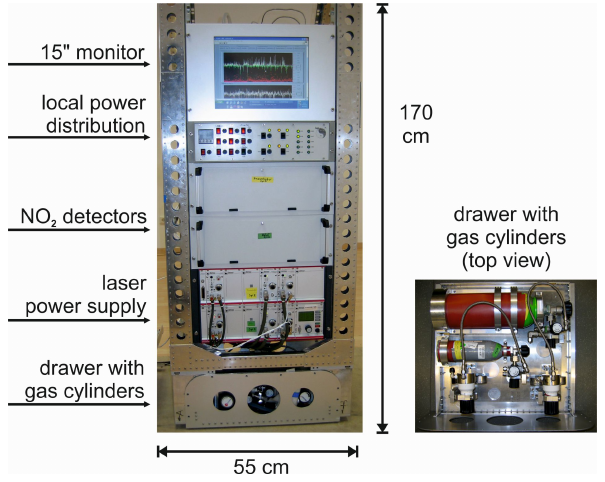
Fig. 2. PeRCEAS rack front side. Rack components which are not visible: PXI computer, temperature-, pressure- and flow controllers, and HALO power supply unit.